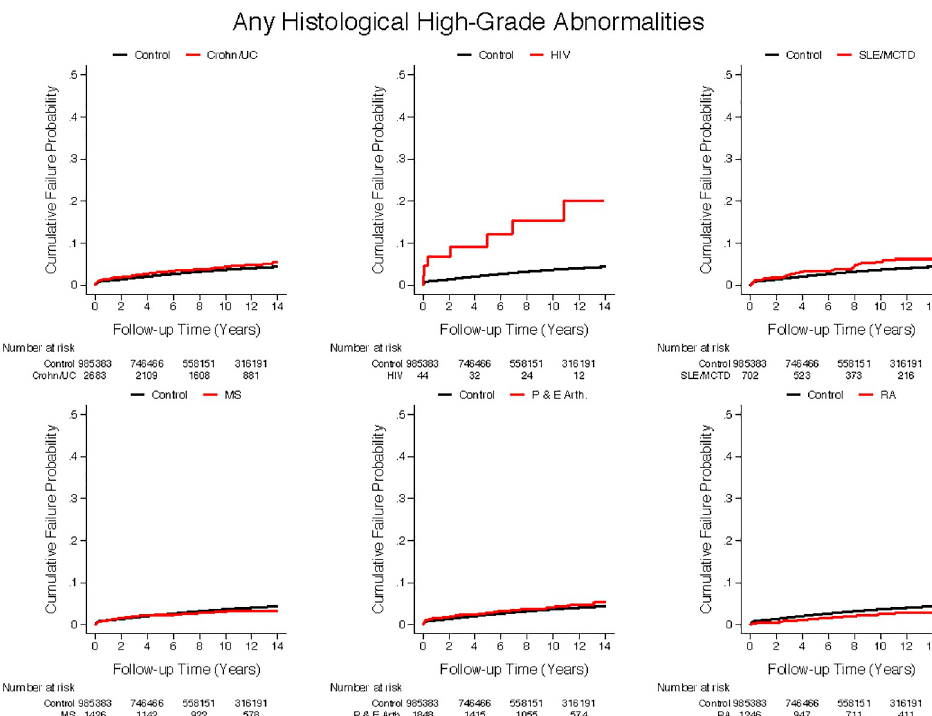
Fig 3. Cumulative incidence of histological high-grade abnormalities. Cumulative incidence of histological high grade abnormalities compared to healthy controls in a) Crohn’s disease/Ulcerative colitis. b) HIV c) SLE/MCTD d) MS e) Psoriatic and enteropathic arthropathy and f) RA. UC = Ulcerative colitis; HIV = Human immunodeficiency virus; SLE/MCTD = Systemic Lupus Erythematosus/ Mixed Connective Tissue Disease; MS = multiple sclerosis; P&E = psoriatic arthritis enteropathic arthropathy; RA = Rheumatoid arthritis.